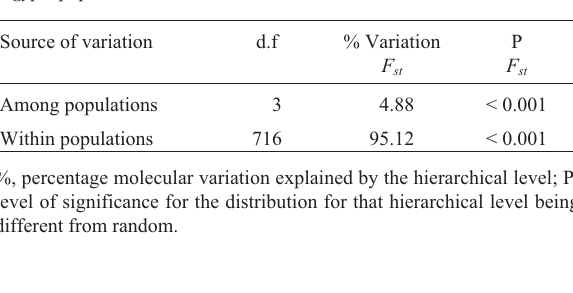
Table 4 - Hierarchical analysis of molecular variance of four Aedes aegypti populations from Manaus.